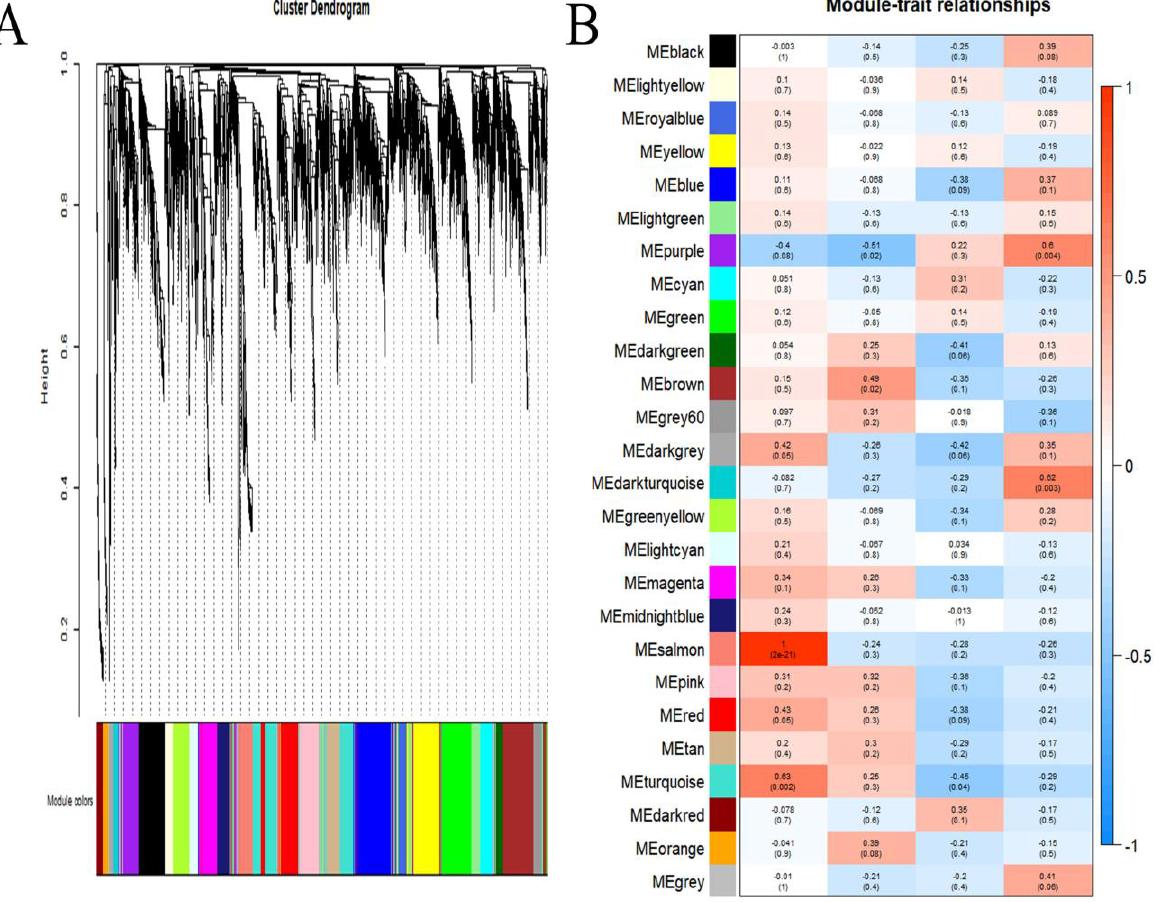
Figure 3. Co-expression network of traits related to S. scitamineum infection. ( A ) Co-expression gene modules of all expression profiles. A total of 26 distinct gene modules were identified. ( B ) Correlation of co-expressed gene modules and traits. The correlation coefficient and p -value are shown in each cell.